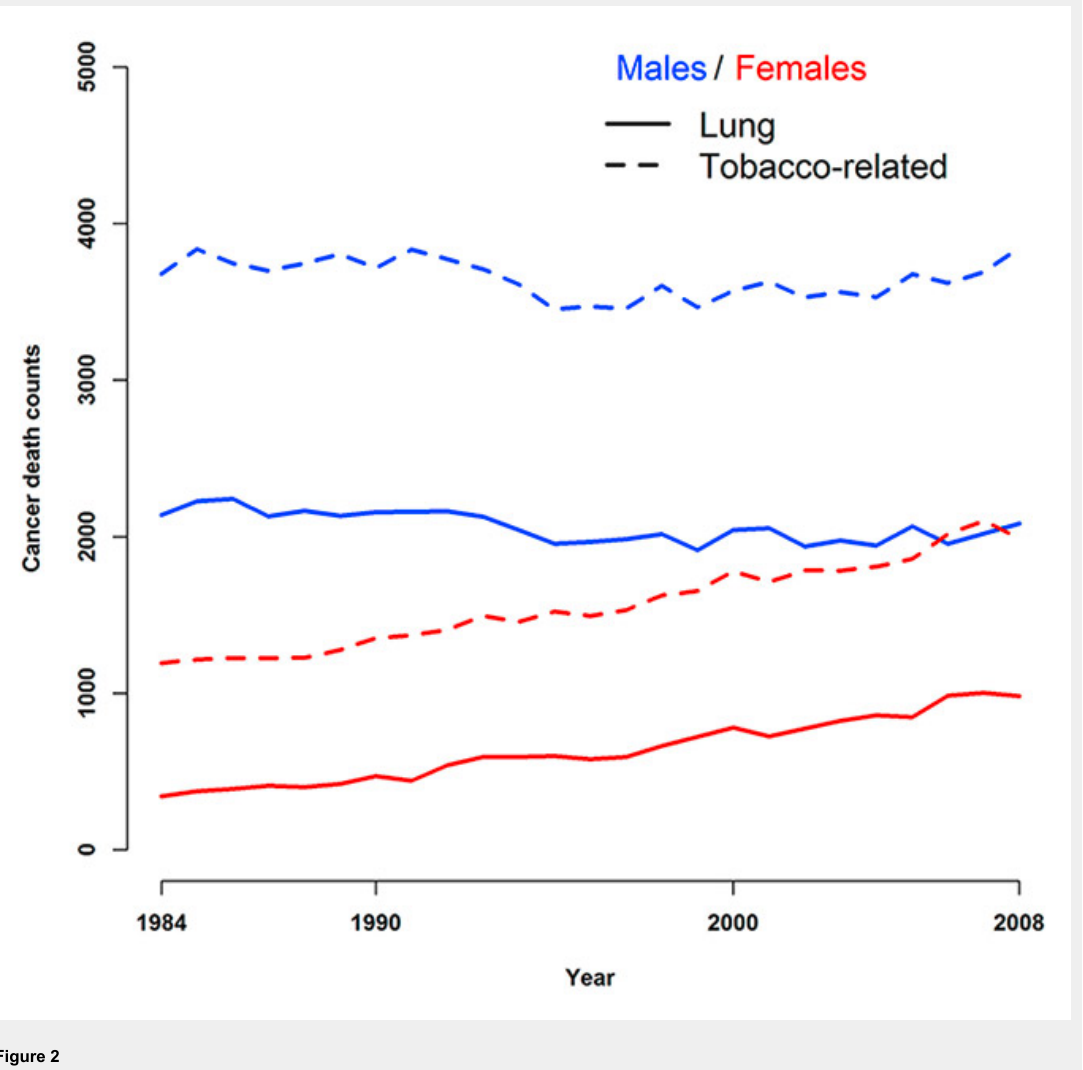
Figure 2 Overall lung and all tobacco-related cancer deaths observed during 1984–2008 at the national level for males and